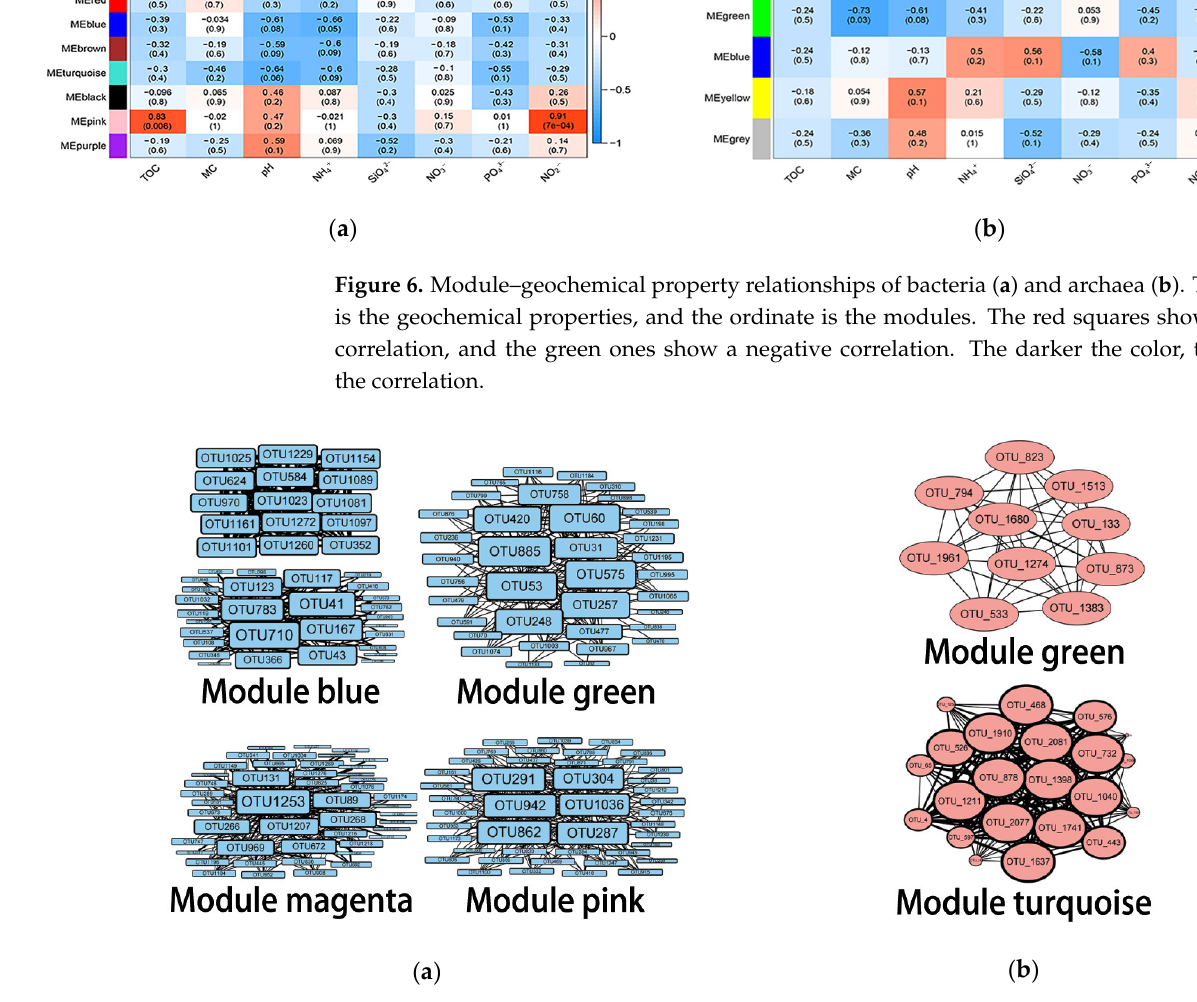
Figure 7. The network diagrams of bacteria ( a ) and archaea ( b ). The nodes represent OTUs, and the lines represent the connections between them. The bigger the size, the stronger the correlation of this OTU with others, and the larger the weight value of the OTU is to identify it as the hub OTU. A total of 200 OTUs were used to draw the network diagrams, which resulted in two networks in module blue of ( a ). However, they will eventually be connected through the OTUs with a relatively low weight value. Table 4. Hub OTUs of bacteria and